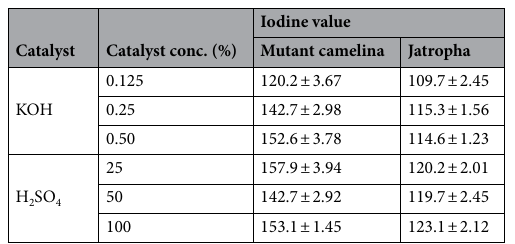
Table 8. Iodine values of biodiesel from mutant camelina and jatropha.